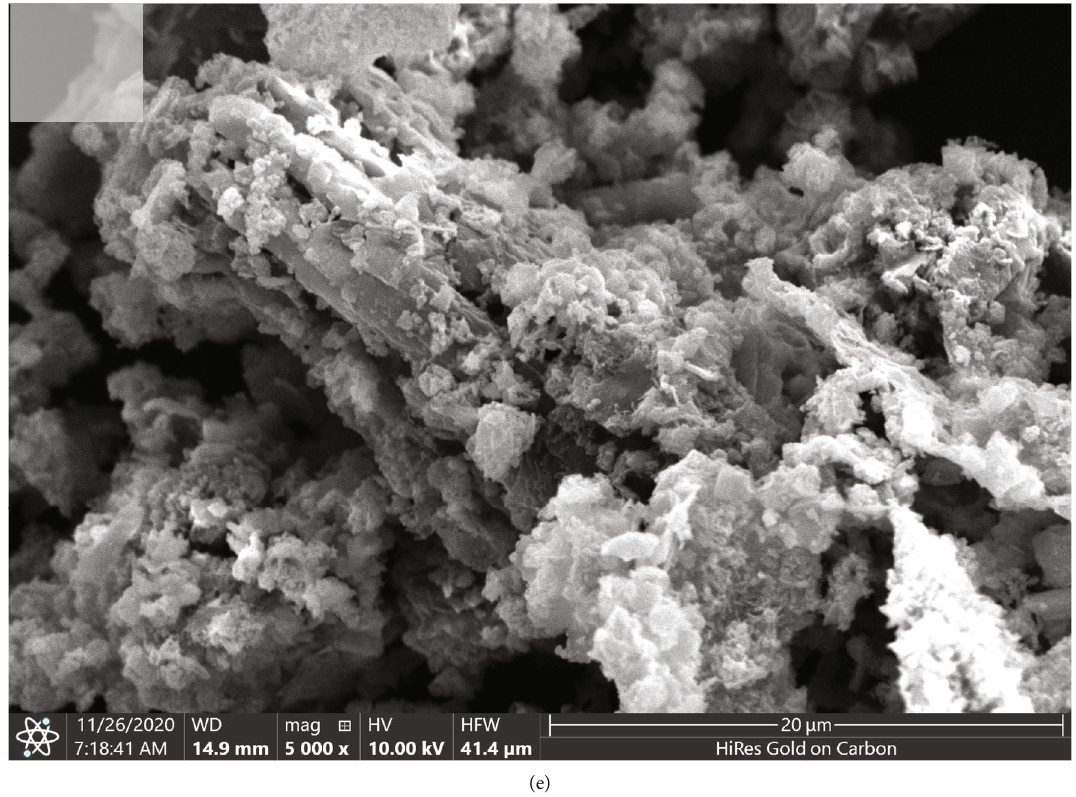
Figure 6: SEM images of MHT (a), polyaniline (b), 0.5 Pan/MHT (c), 1 Pan/MHT (d), and 2 Pan/MHT